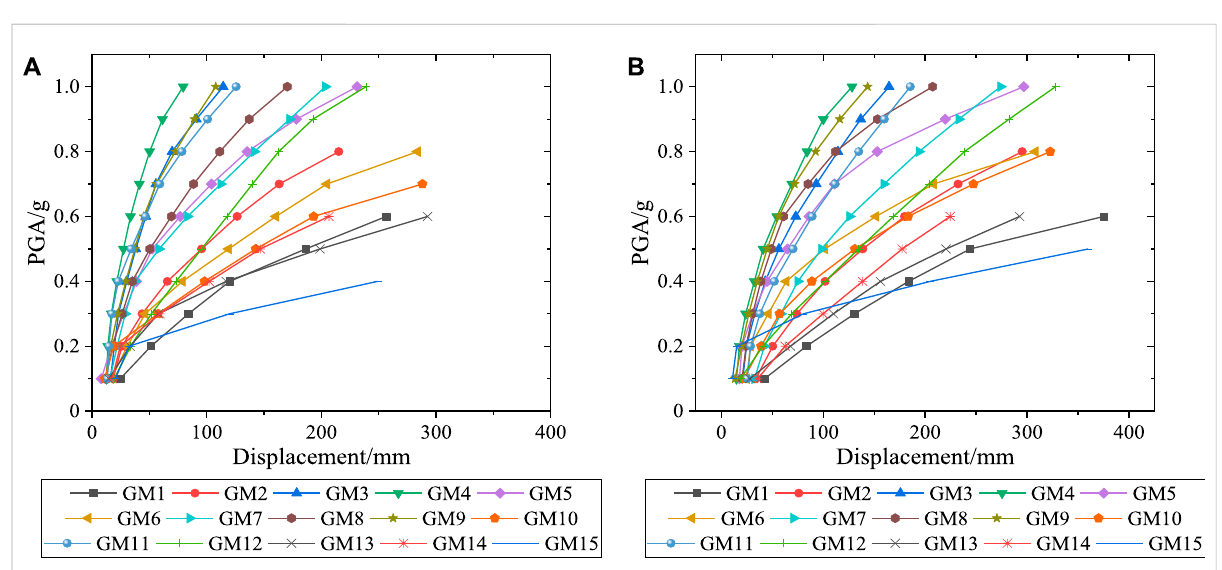
Horizon displacement of isolated layers: (A) Base isolated layer, (B) Upper isolated